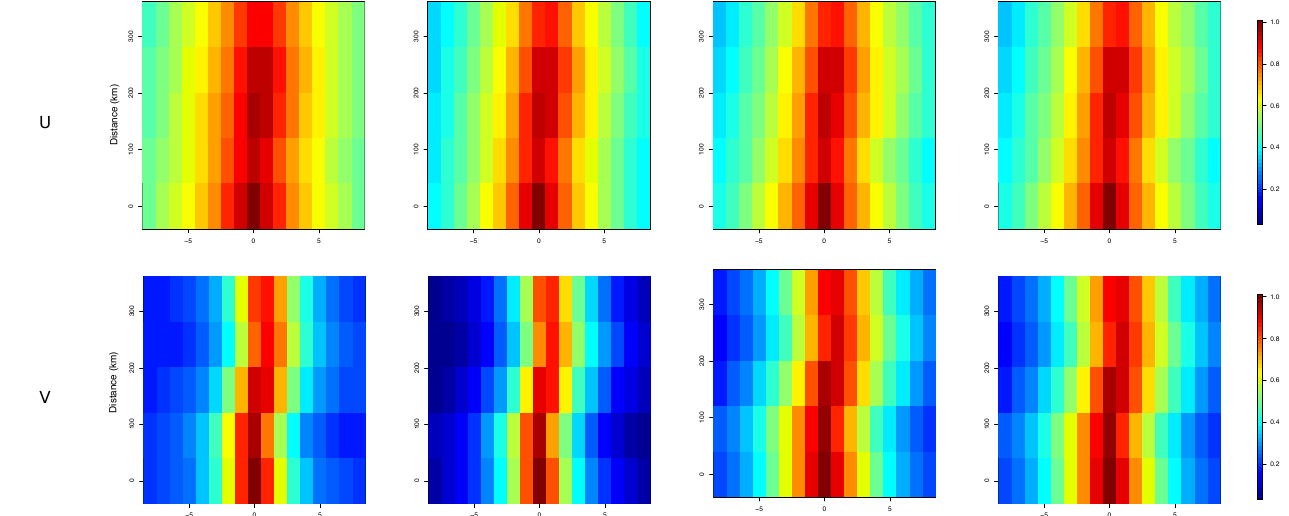
Figure 9. Top: correlation of between { u t } at site 1 and { u t } at the other locations (sorted according to increasing distance) at various time lags. Bottom: similar quantities for { v t } . From the top panel to the bottom one: data and simulation from VAR(2), from AP-MS-VAR C and from H-MS-VAR.